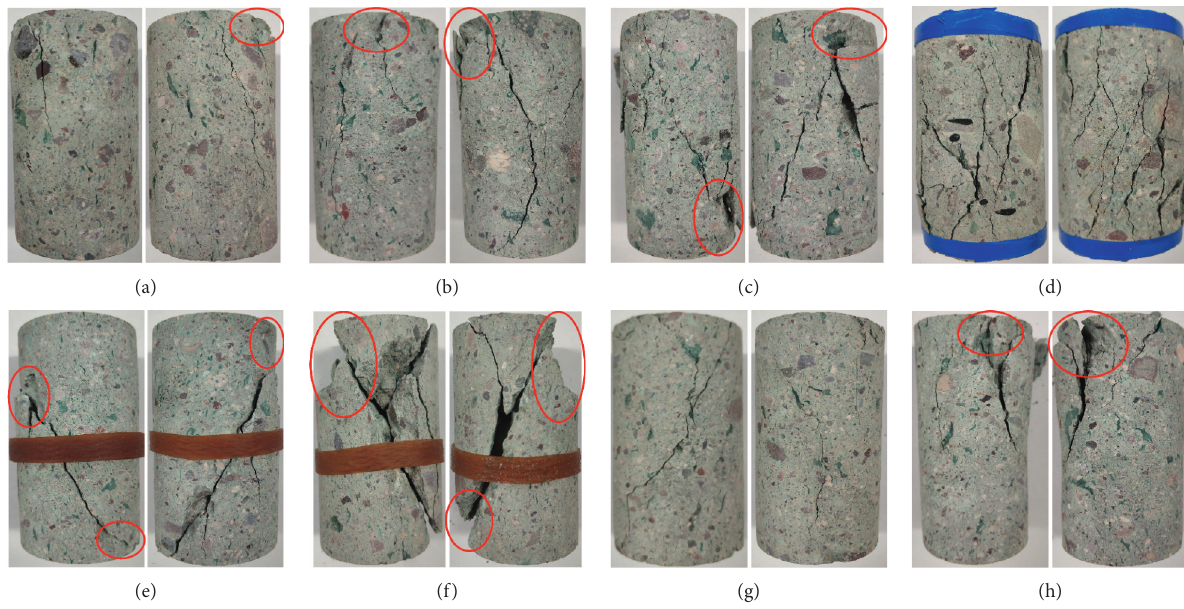
Figure 13: Failure samples of tuff after different stress path tests: (a) NF1; (b) FT1-3; (c) NF2; (d) FT2; (e) NF3; (f) FT3; (g) NF4; (h)